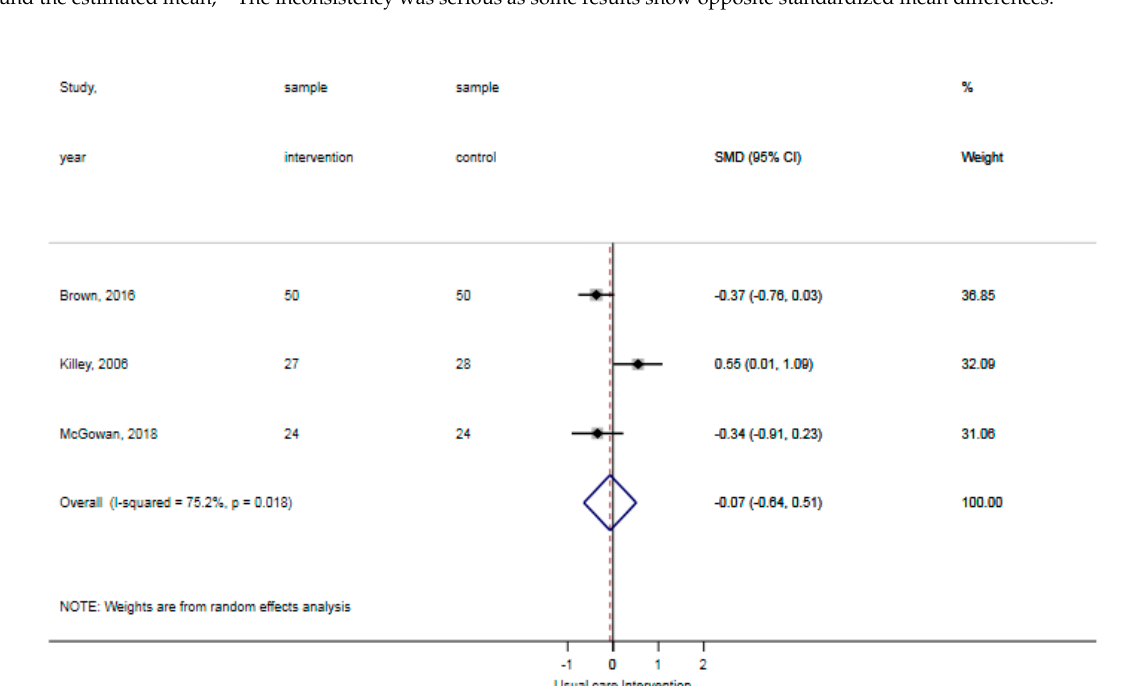
Figure 3. Forst plot time spent standing and walking showing no statistically significant difference between usual care and intervention.